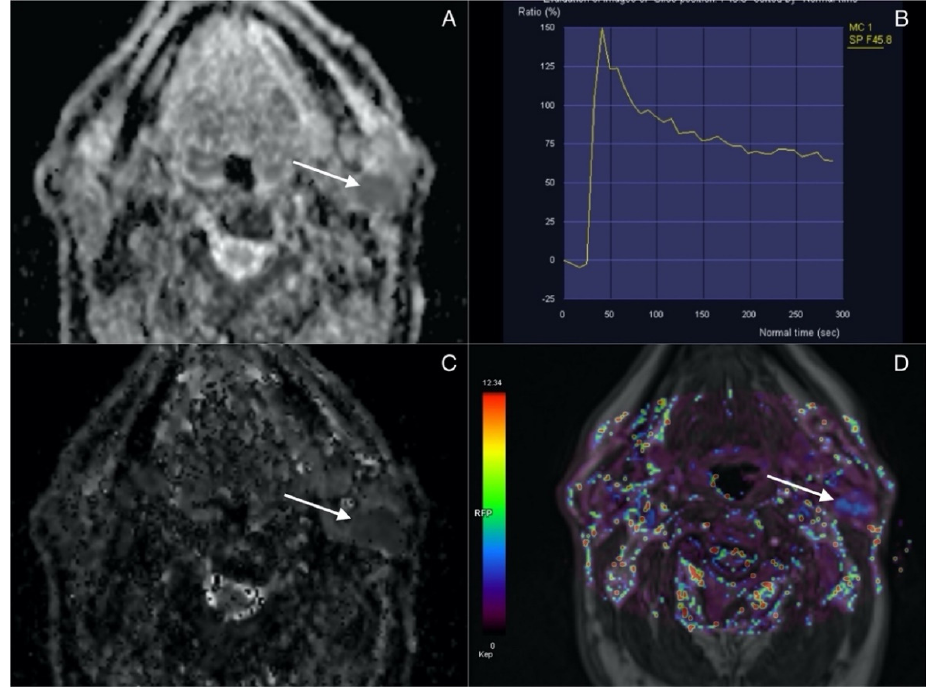
Figure 3. Warthin tumor (arrow) in superficial lobe of the left parotid. ( A ) ADC map. Lesion presents with low signal intensity correlating with diffusion restriction. ( B ) Time intensity curve showing rapid contrast agent uptake with high-rate washout corresponding to type B curve typical for WT. ( C ) IVIM. D map (low values). ( D ) Permeability. Kep map (high values).